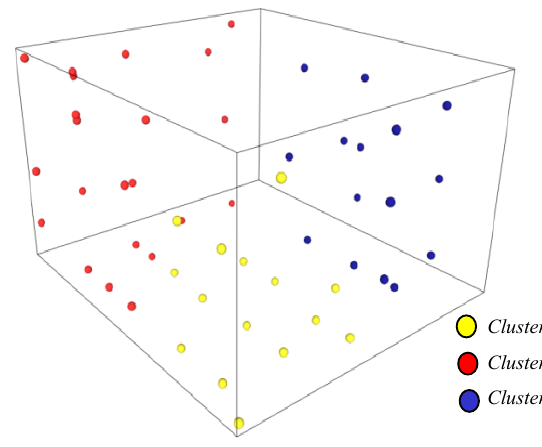
Figure 1. Clusters with k = 3 for franchising restaurant.